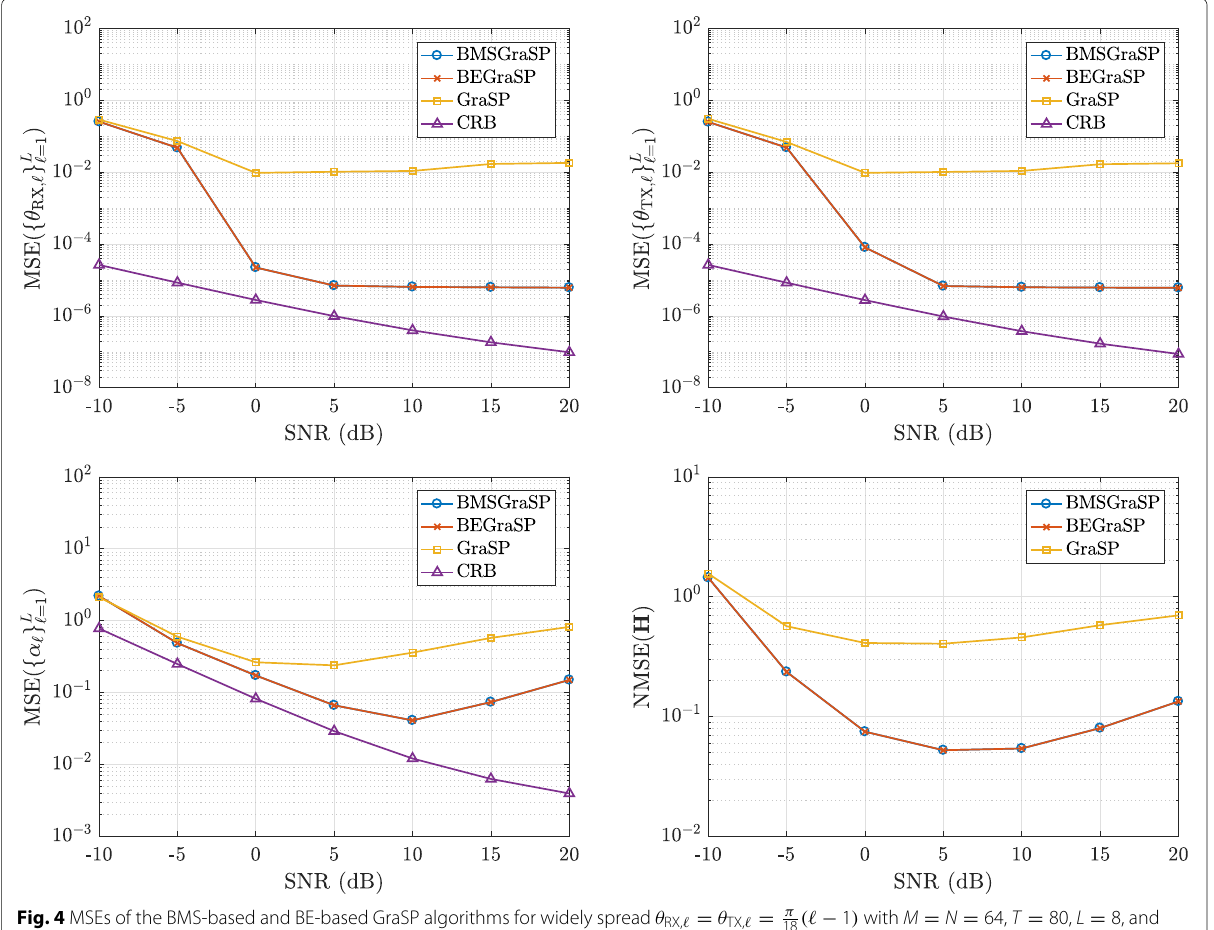
Fig. 4 MSEs of the BMS-based and BE-based GraSP algorithms for widely spread θ RX, (cid:6) = θ TX, (cid:6) = π α (cid:6) = ( 0.8 + 0.1 ((cid:6) − 1 )) e j π 4 ((cid:6) − 1 ) . The CRB is provided as a reference, which was derived in